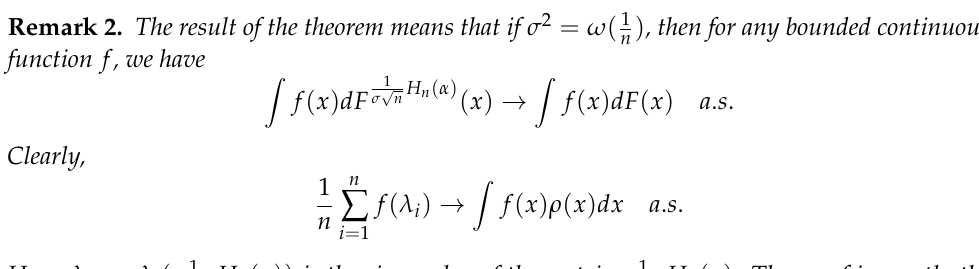
Figure 1. Simulation for Theorem